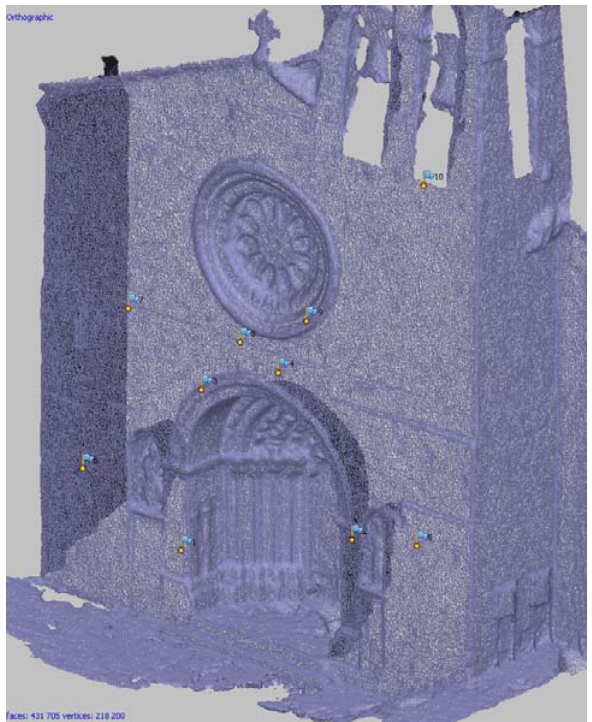
Figure 12. Mesh (orthographic perspective) generated from the Dense Point Cloud: 218,200 vertex and 431,705 faces.